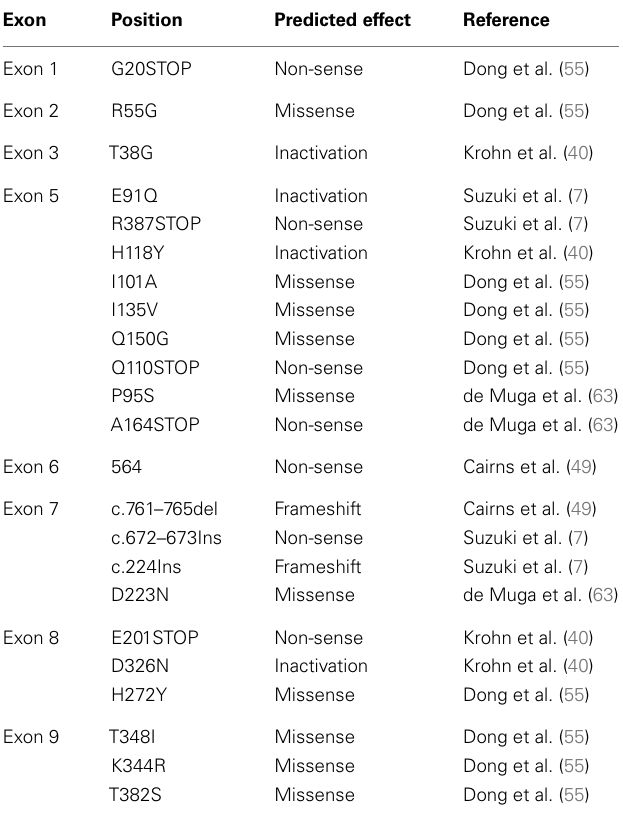
Table 1 | Mutations in the PTEN gene identified in prostate